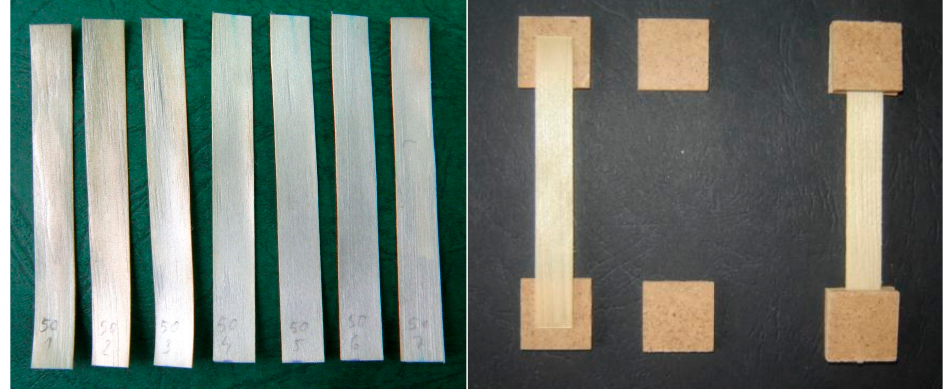
Figure 4. Sliced microtome samples and samples with reinforced grips.